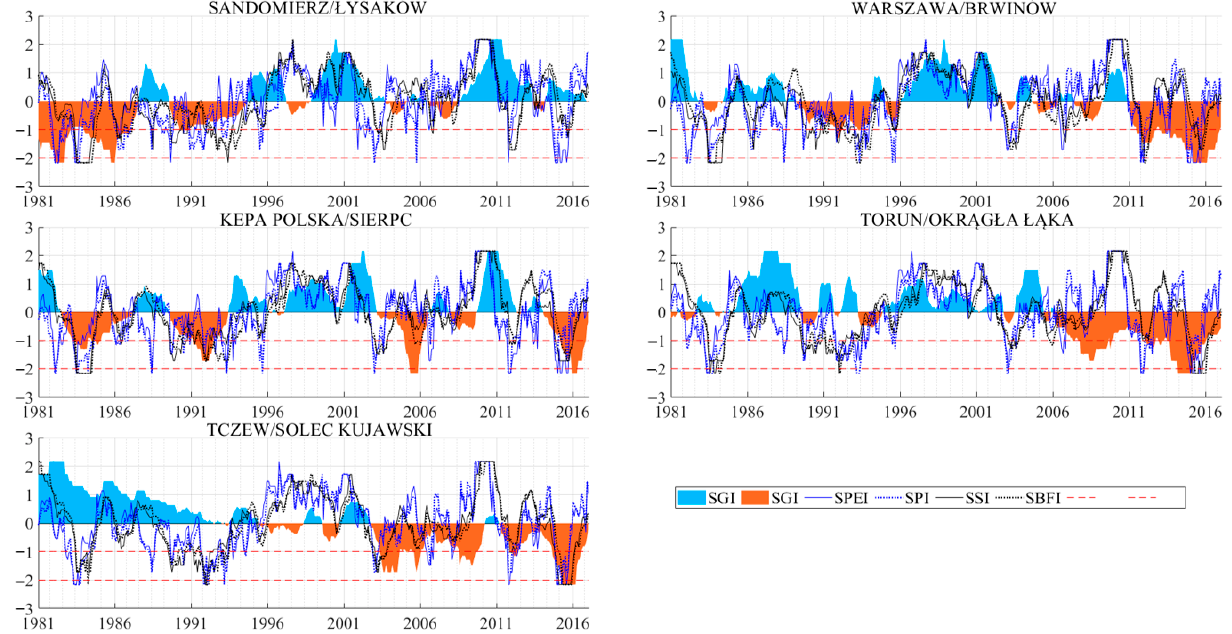
Figure 13. Comparison of standardized drought indices based on a 12-month accumulation period for the Vistula basin at five gauging and ground monitoring stations. SGI is shown as the colored area, SPEI is shown with a blue solid line, SPI is shown with a blue dotted line, SSI is shown with solid black line, and SBFI is shown with a black dotted line.